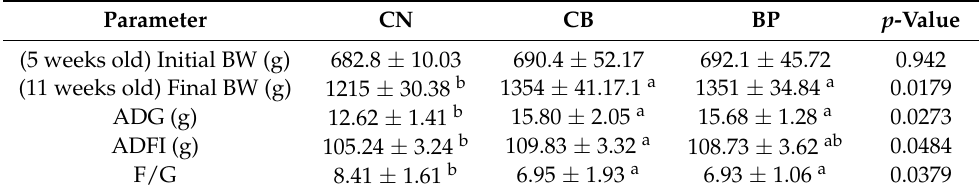
Table 1. Effects of dietary CN, CB, or BP supplementation on the growth performance of rabbits. Parameter CN CB BP p -Value